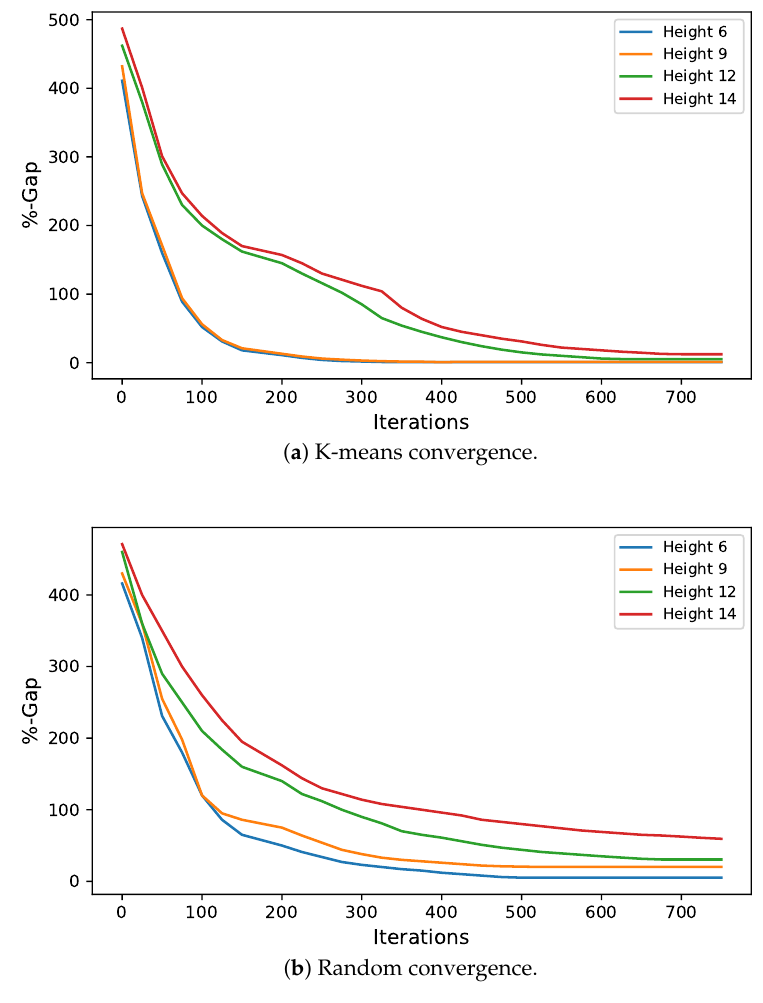
Figure 10. K-means and Random convergence chart for cost